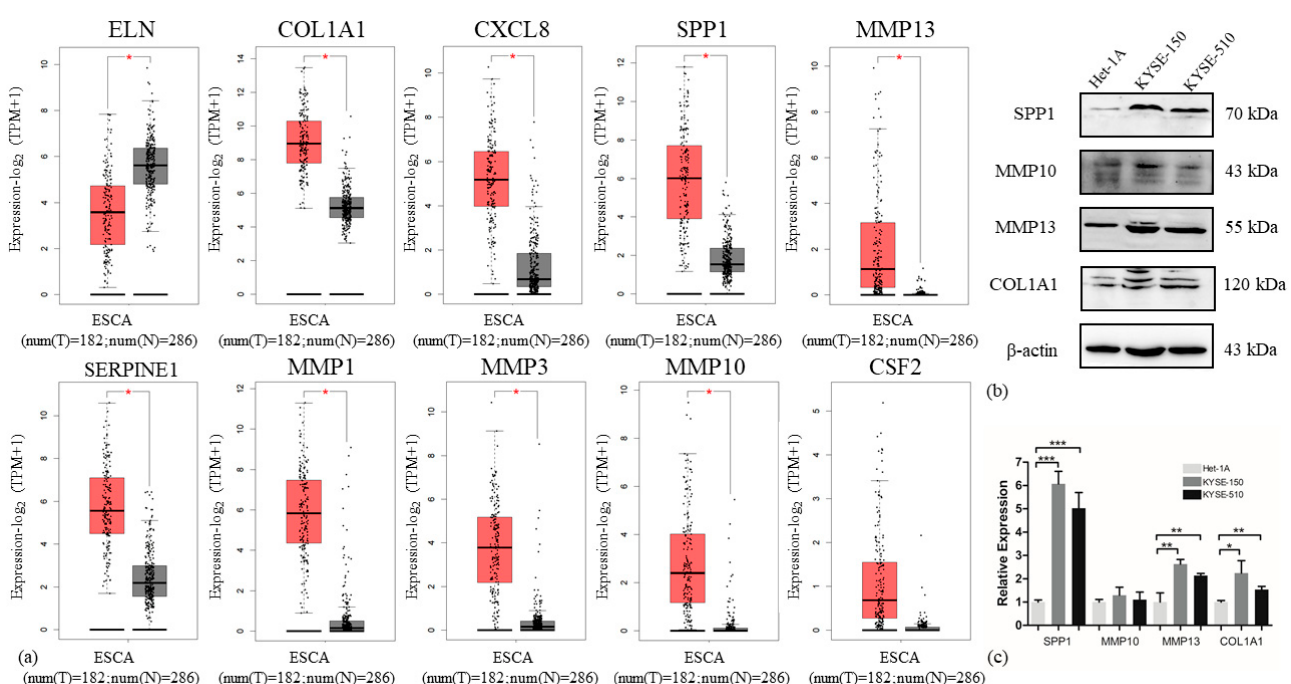
Figure 8. Validation of the DEGs by GEPIA2 and Western blot. ( a ) The top 10 genes expression in ESCA from GEPIA2 database (* p < 0.05); ( b ) Expression of four key genes (SPP1, MMP10, MMP13 and COL1A1) evaluated by Western blot; ( c ) Western blot quantification (each protein expression was normalized against expression level of β -actin and Het-1A cell line, * p < 0.05, ** p < 0.005, *** p <